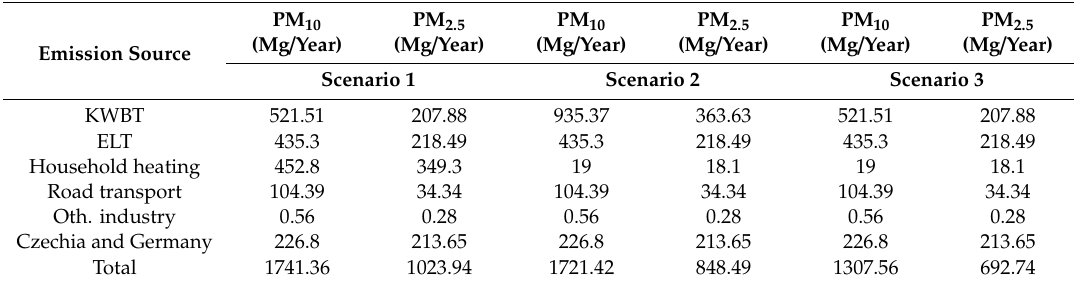
Table 5. Emission for individual sources included in the calculations for individual